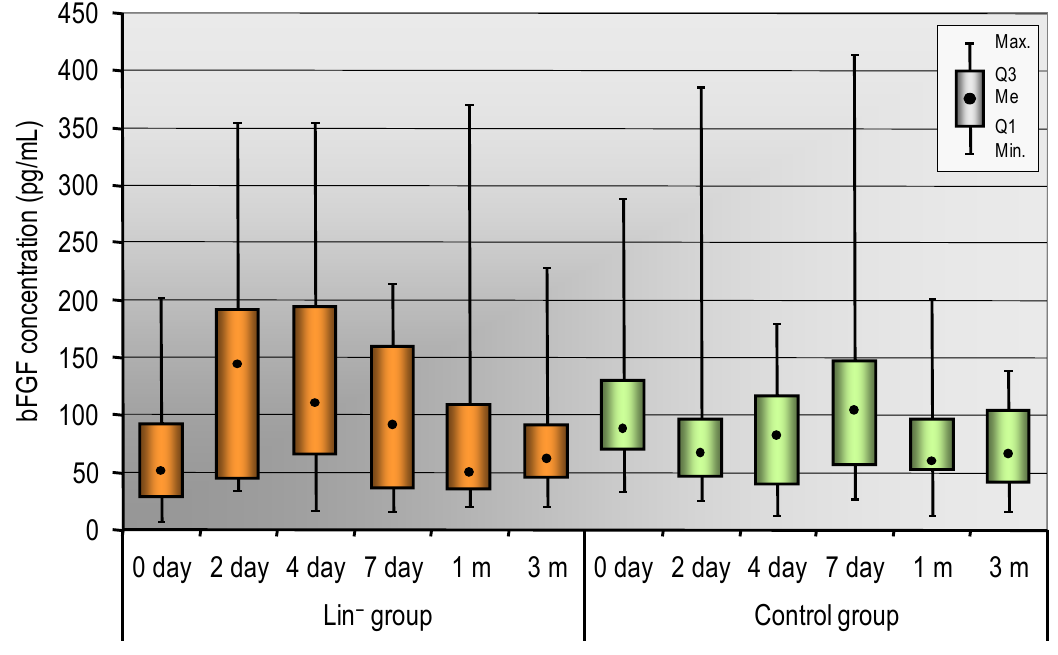
Figure 2. The plasma levels of bFGF in the Lin − group and in the control group (day 0, 2, 4, and 7 and in month 1 and 3); m: month. Data are presented as medians (lower – upper quartiles). 2.5. Correlation between Selected Neutrotrophins and Angiogenic Factor Concentration with the Number